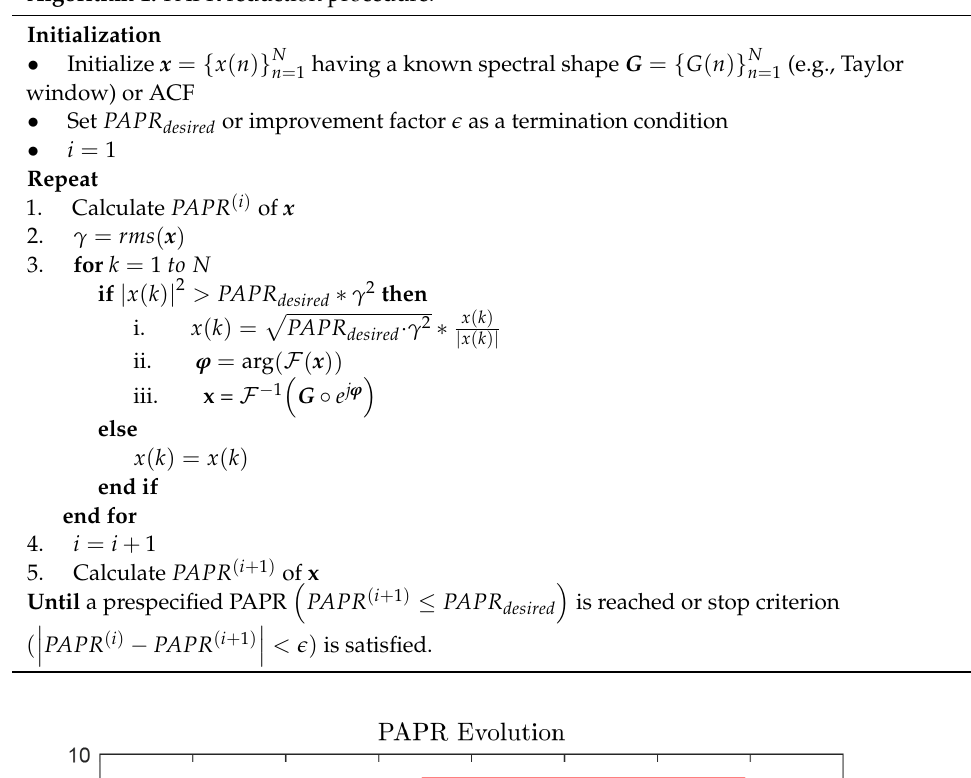
Algorithm 1. PAPR reduction procedure.